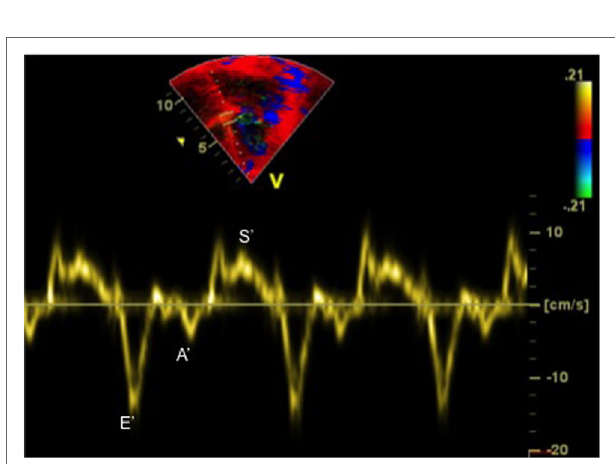
FigURe 5 | Tissue Doppler imaging tracing obtained at the septal annulus showing S ′ (systolic) wave, E ′ (early diastolic) wave, and A ′ (late diastolic related to atrial contraction) wave.